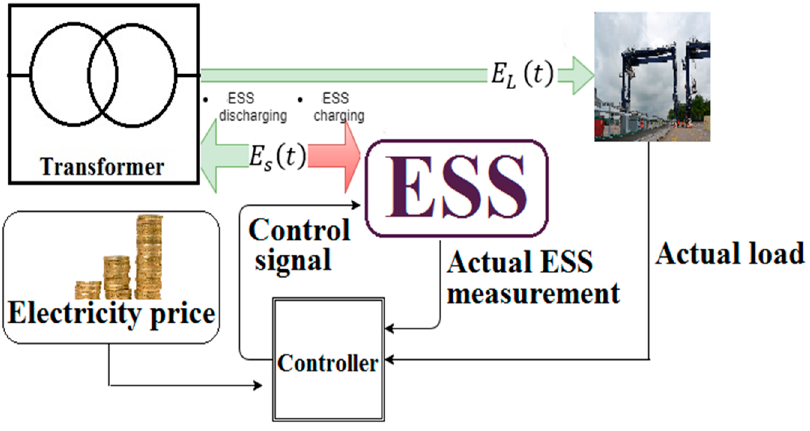
Figure 5. The schematic of the optimal energy management controller.